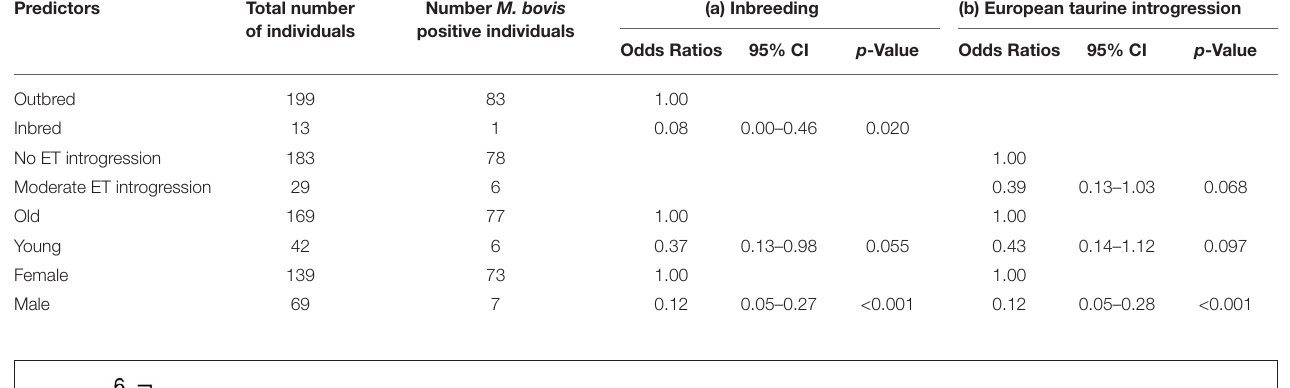
TABLE 2 | Association between (a) inbreeding and (b) European taurine introgression and M. bovis after accounting for age and sex ( n = 207). Predictors Total number Number M. bovis of individuals positive individuals